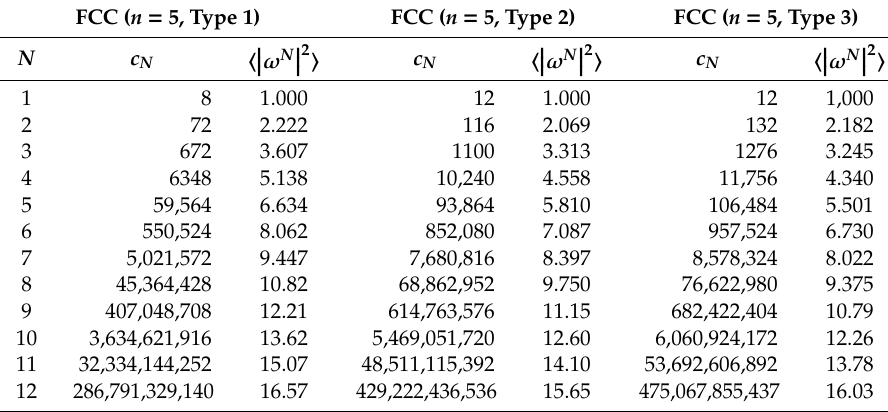
Table A12. Properties of SAWs on FCC lattice with 5 layers between the confining plates ( n = 5, Type 1, 2, 3).